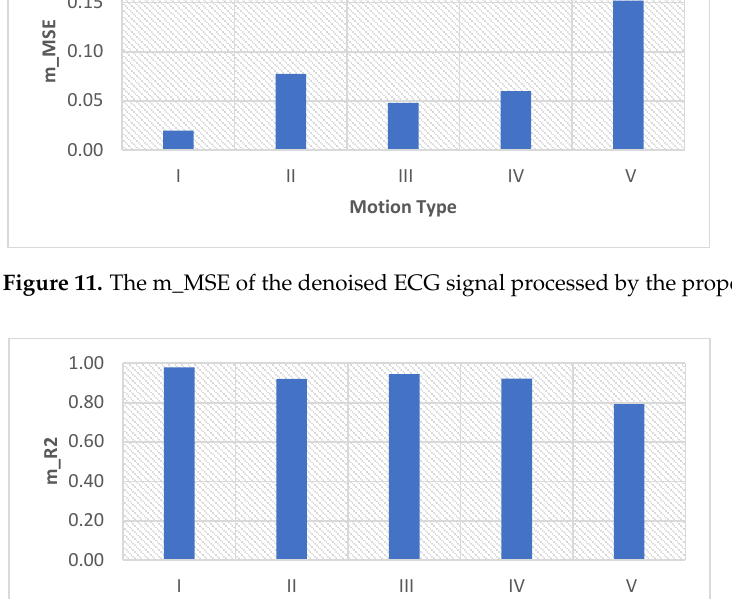
Figure 12. The m_R 2 of the denoised ECG signal processed by the proposed method.